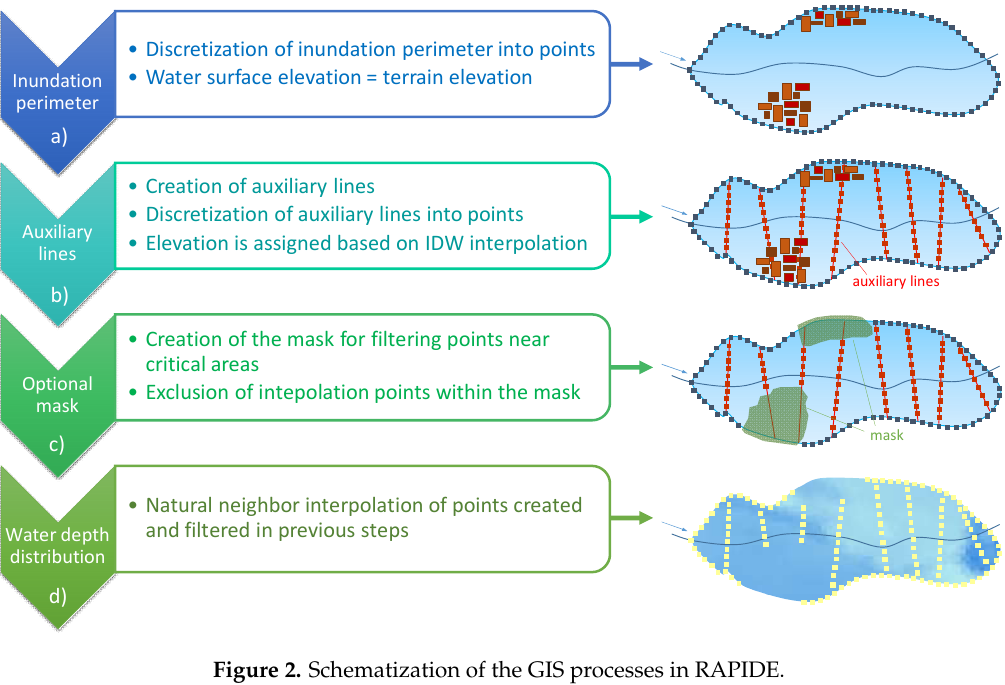
Figure 2. Schematization of the GIS processes in RAPIDE.